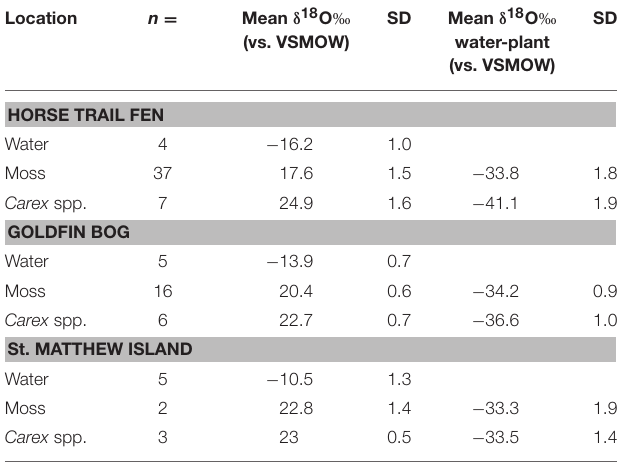
TABLE 5 | Plant and water isotope summary and statistics.